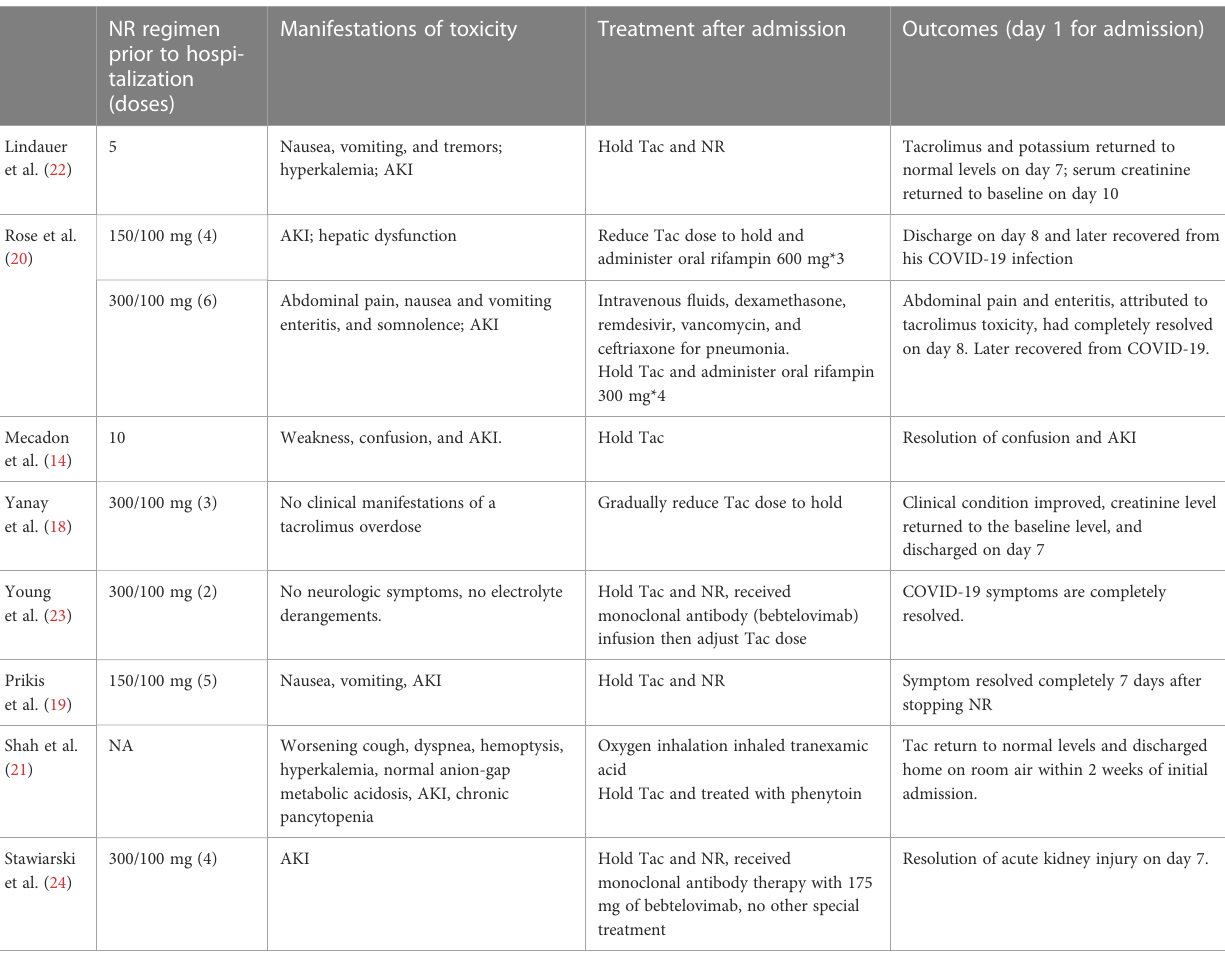
TABLE 3 Manifestations and outcomes of cases of keeping